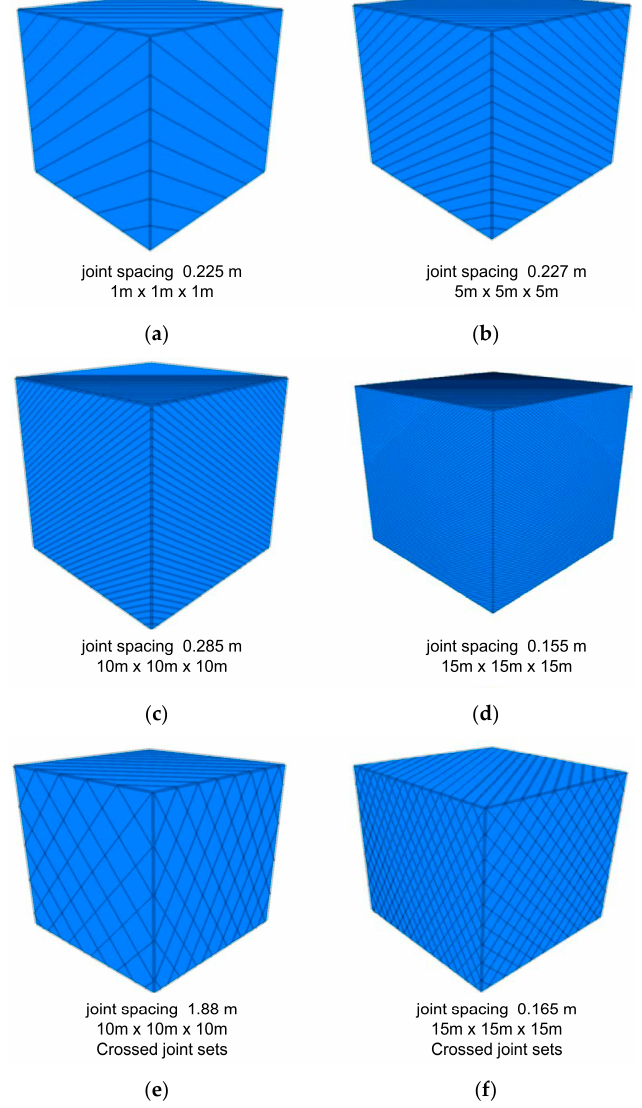
Figure 6. Simulated coal samples with the different joint densities. ( a ) joint spacing 0.225 m, 1 m × 1 m × 1 m; ( b ) joint spacing 0.227 m, 5 m × 5 m × 5 m;( c ) joint spacing 0.285 m, 10 m × 10 m × 10 m; ( d ) joint spacing 0.155 m, 15 m × 15 m × 15 m; ( e ) joint spacing 1.88 m, 10 m × 10 m × 10 m, Crossed joint sets; ( f ) joint spacing 0.165 m, 15 m × 15 m × 15 m, Crossed joint